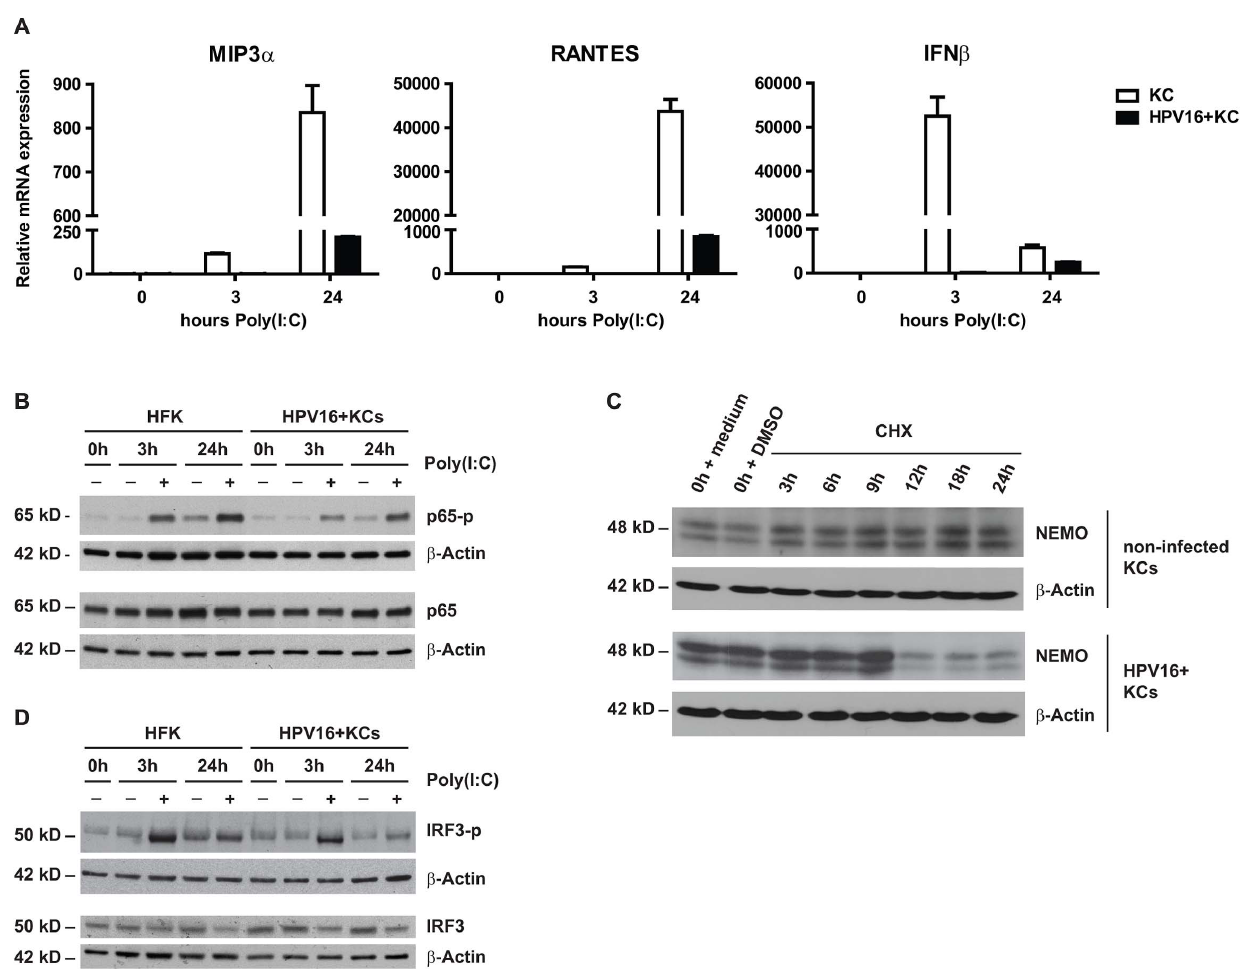
Figure 2. Canonical NF- k B signaling is impaired upstream of the transcription factor p65. ( A ) Poly(I:C) induced cytokine expression in HPV16 + KCs compared to non-infected KCs. MIP3a , RANTES and IFN b expression was measured by qRT-PCR. Gene expression was normalized using GAPDH mRNA levels and standardized against 0 h of stimulation with poly(I:C). ( B ) Poly(I:C) stimulated phosphorylation levels of p65 in HPV16 + KCs compared to non-infected KCs. Total p65 levels and p65 phosphorylation status were determined in whole cell extracts by western blotting. b -actin served as loading control. ( C ) NEMO degradation in HPV16 + KCs compared to non-infected KCs. Monolayer cultures were treated with 100 m M cycloheximide (CHX) and harvested after 0, 3, 6, 9, 12, 18 and 24 hours. Whole cell extracts were analyzed by western blotting using antibodies against NEMO and b -actin (control for protein degradation). ( D ) Poly(I:C) stimulation-induced phosphorylation levels of IRF3 in hrHPV + KCs compared to KCs. Total IRF3 levels and IRF3 phosphorylation status were determined in whole cell extracts by western blotting. b -actin served as loading control.